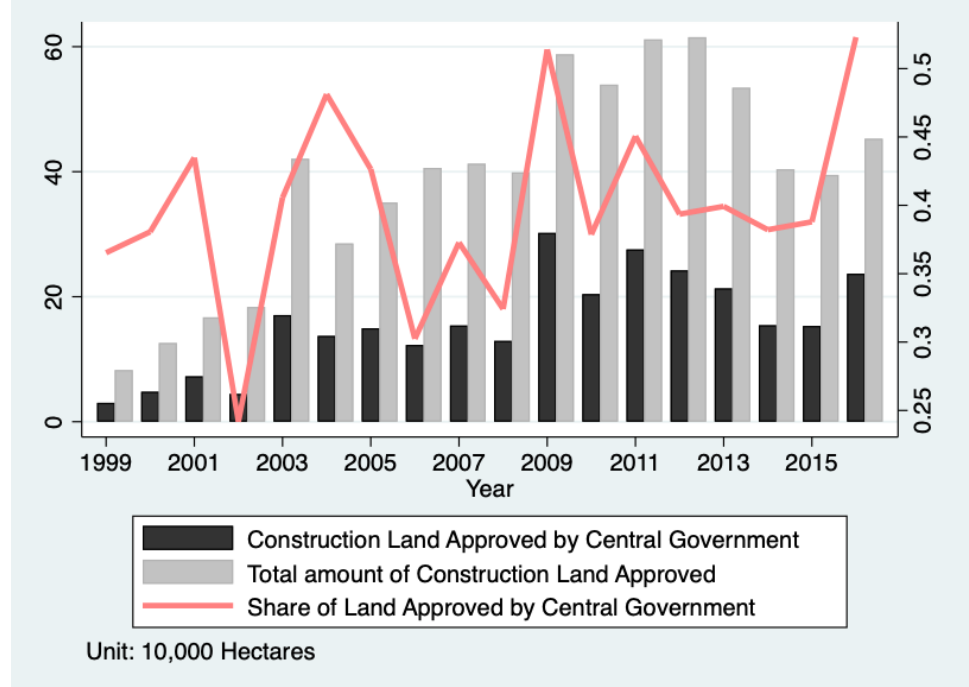
Figure 5. Land approved by central government and provincial